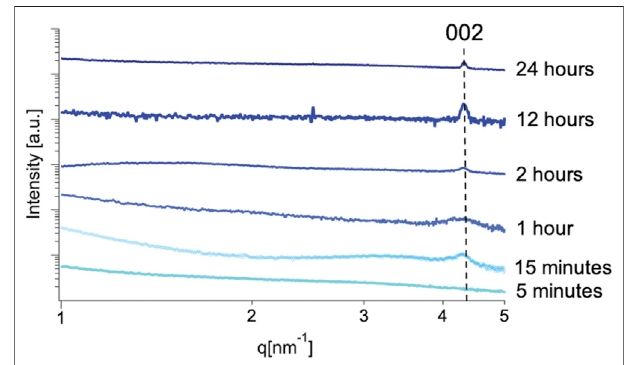
FIGURE5| SolutionSAXS pro fi les ofearlystage mithrene samplesfrom 5 min to 24 h. Each pro fi le has been normalized to intensity. Qualitatively, the pro fi les in the lower q regime differ signi fi cantly. This could be attributed to aggregation of sample in solution, as non-ideal solution was used and samplesfromearlytimescaleswillhavelessproductpresence.Thisdifference could also be attributed to the size heterogeneity of the polymer product in solution.